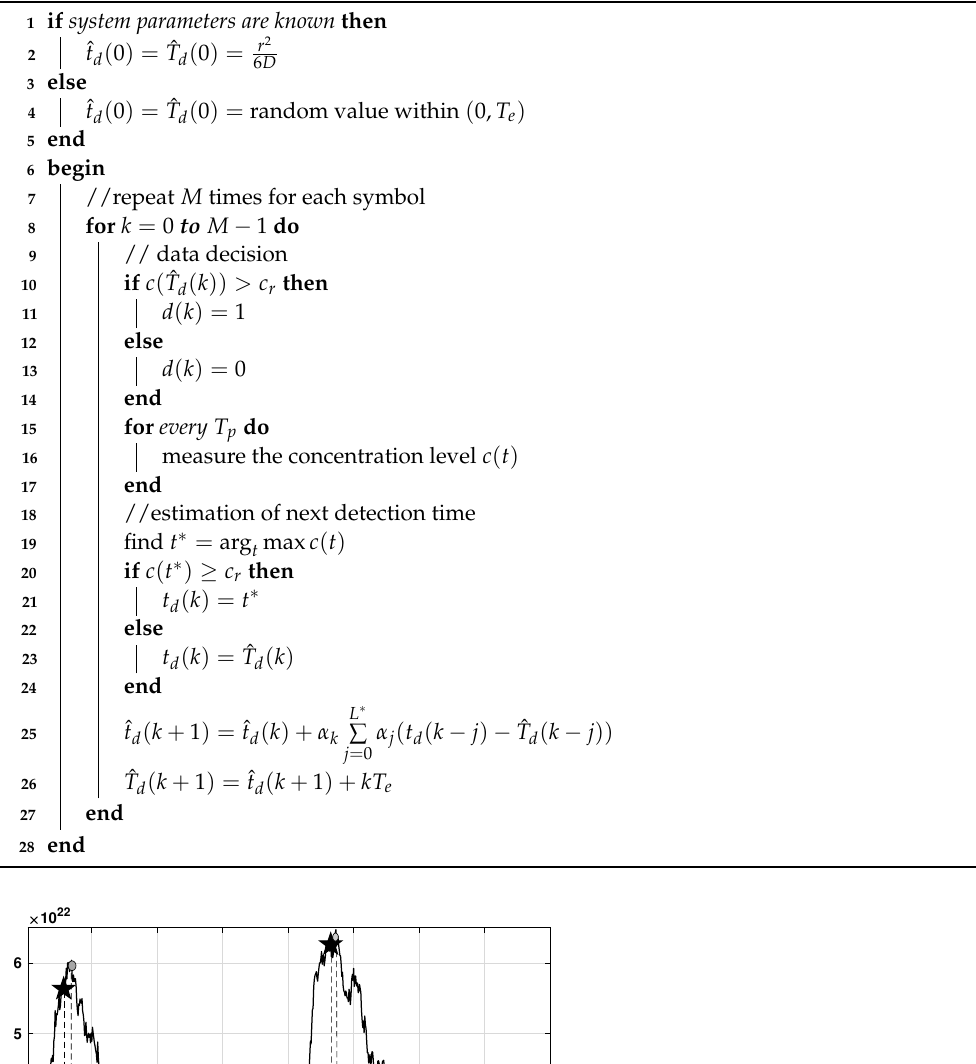
Algorithm 1: Proposed detection method.